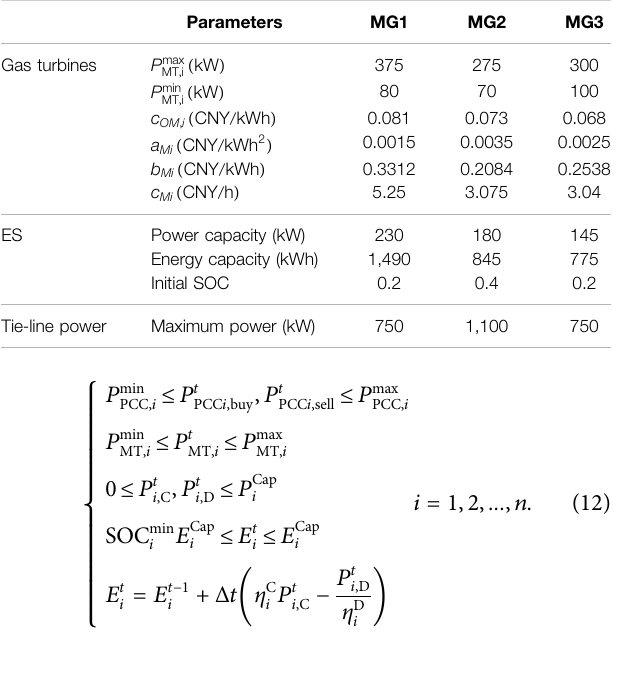
TABLE 1 | Relevant parameters of micro sources in MGs.